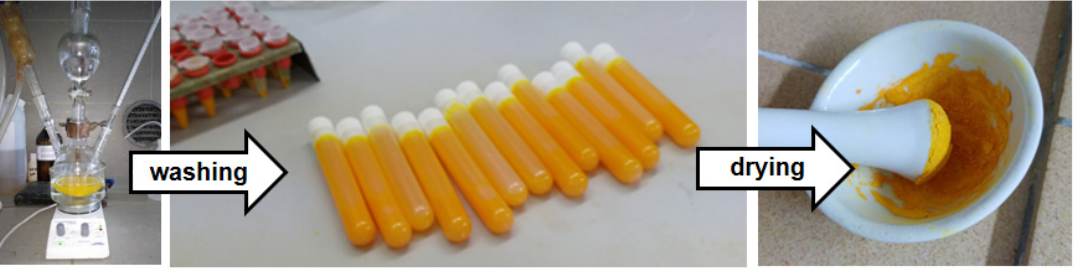
Figure 1. Equipment for CdS NP synthesis.